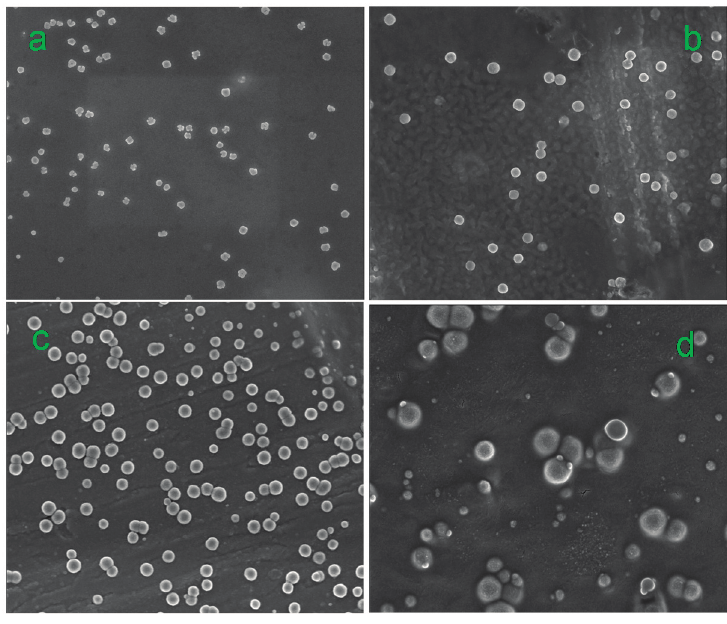
Figure 1. TEM images of molecules of Fenge water decoction. ( a – d ) display the characteristic cluster structure of F-1, F-2, F-3, and F-4.